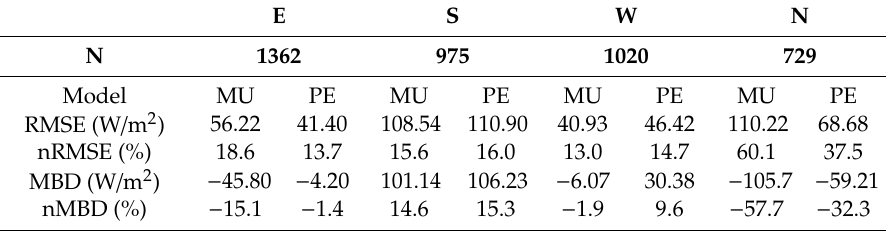
Table 6. Statistic values under clear sky conditions for the experimental testing ground station in Spain.